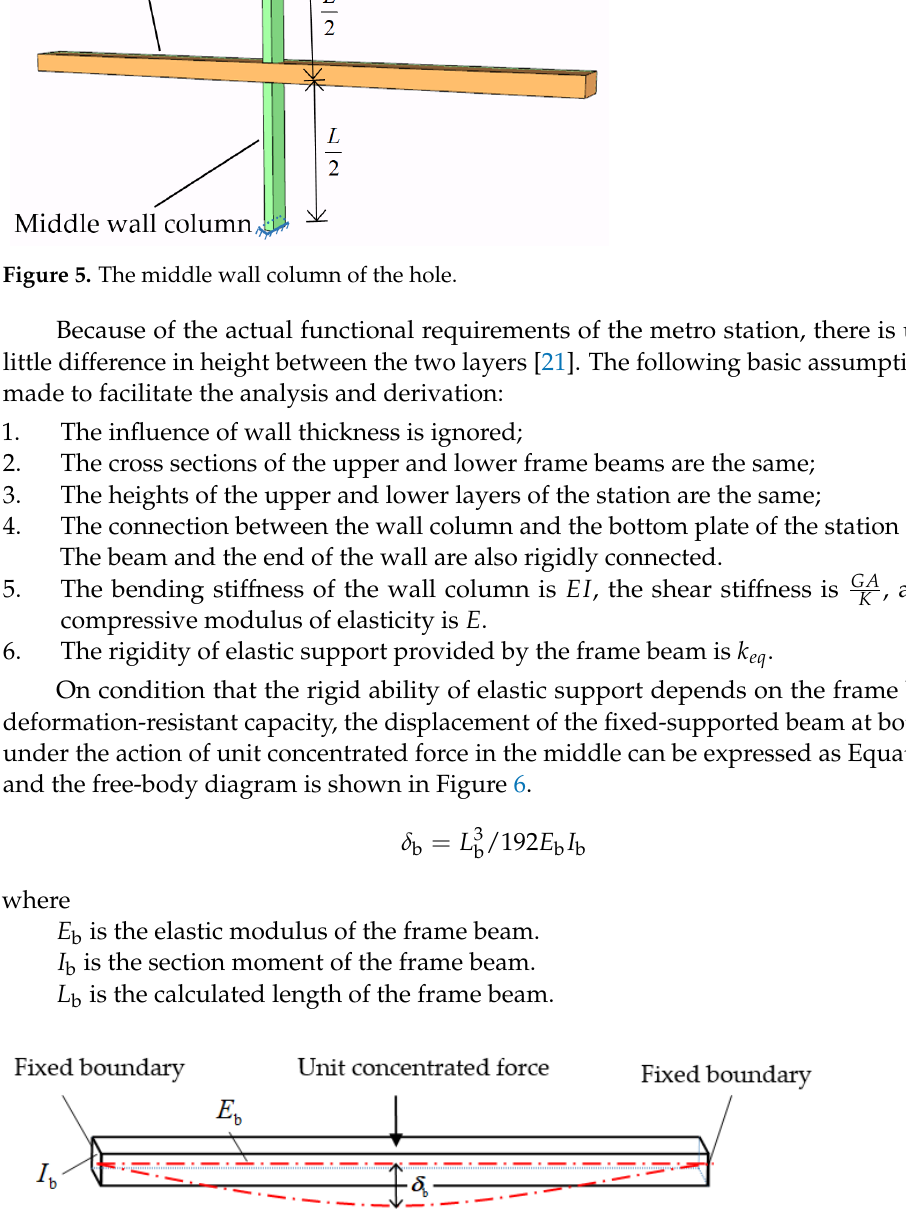
Figure 4. The simplified system composed of wall columns and walls.